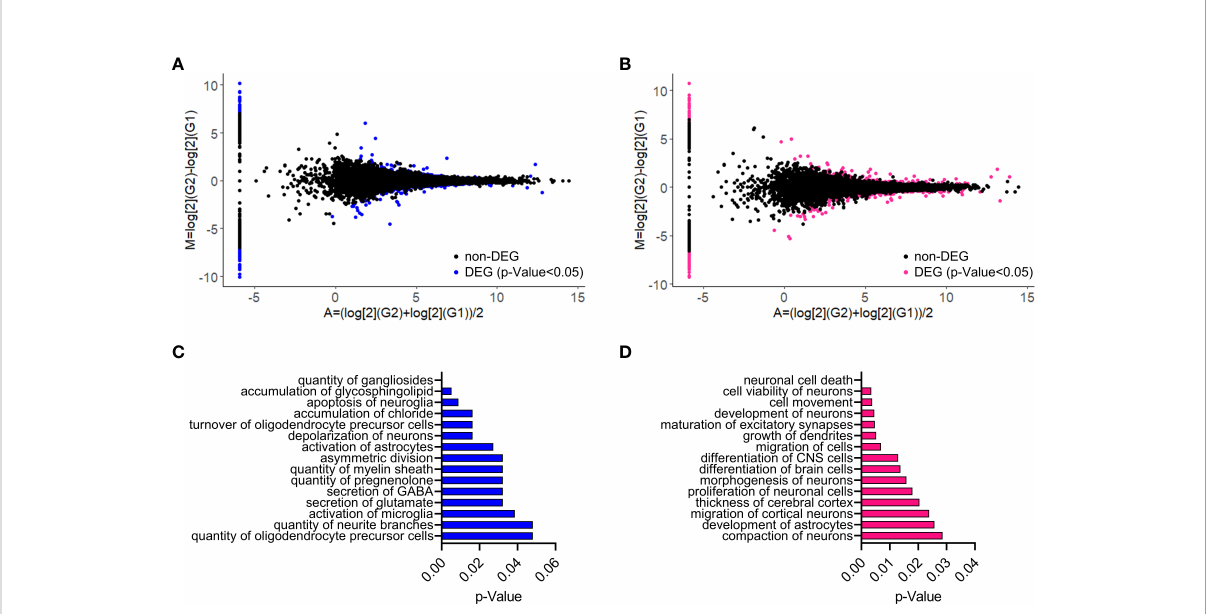
FIGURE 1 Impact of placental ALLO insuf fi ciency on the cerebral cortex transcriptome at P30. (A, B) MA plots for the cortical RNAseq analysis of plKO vs Ctrl mice at P30 in males (A) and females (B) . M, log ratio; A, mean average. DEGs are represented as colored dots (blue for males and magenta for females). (C, D) Top 15 signi fi cant enriched gene functional groups identi fi ed with Ingenuity Pathway Analysis software (Qiagen) in males (C) and females (D) . P-values were calculated using right-tailed Fisher ’ s exact